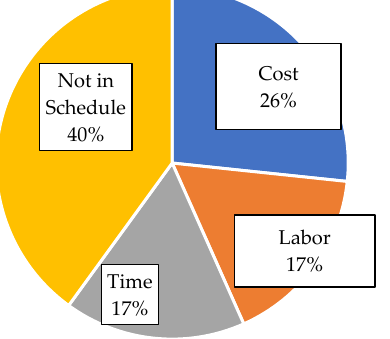
Figure 10. Frequency of C&D waste disposal by the sites.